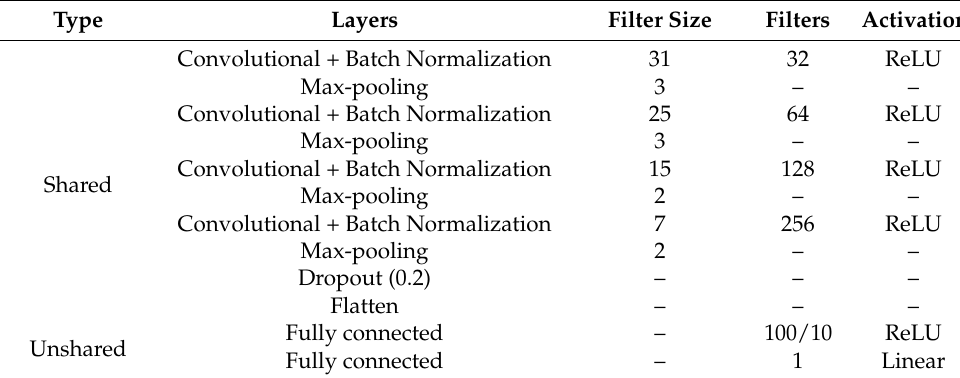
Table 2. Parameters of each layer used in the multitask one-dimensional convolutional neural network (1DCNN)